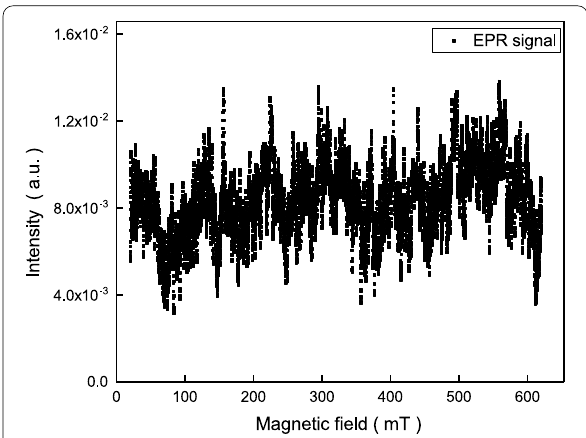
Fig. 2 The electron paramagnetic resonance spectra as a function of magnetic fields. No obvious EPR signal of spin S = 1 2 ,1, 3 2 or 5 2 is observed